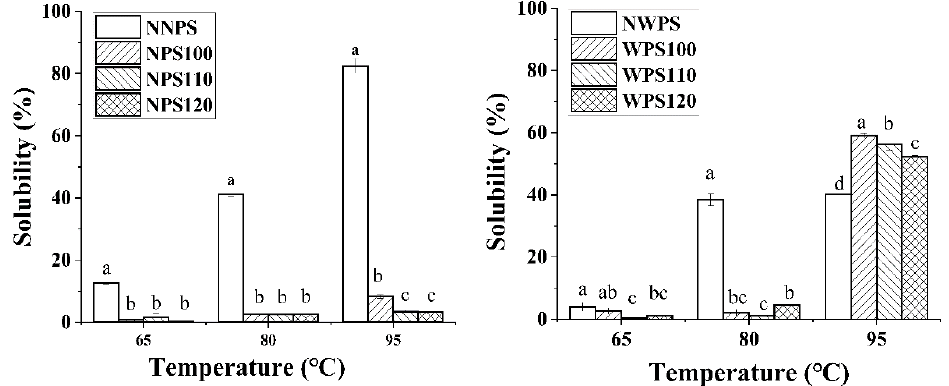
Figure 4. The solubility of the samples. Different letters in a histogram signify significant differences ( p < 0.05).